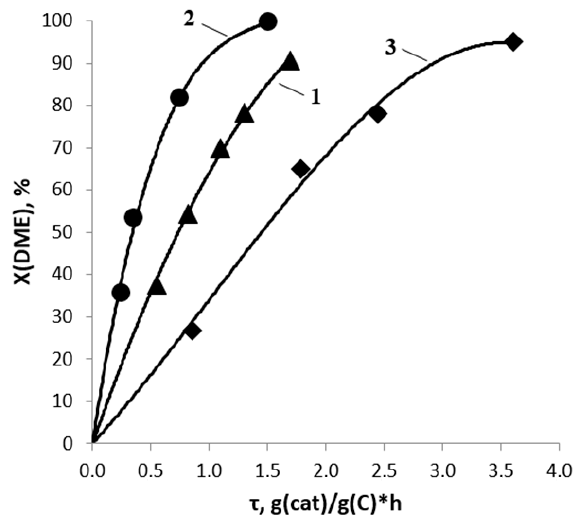
Figure 4. Conversion of DME (X (DME), %) as a function of specific contact time ( τ , g(cat) / g(C)*h). 1—HZSM-5 / Al 2 O 3 ; 2—Zr- HZSM-5 / Al 2 O 3 ; 3—Mg- HZSM-5 / Al 2 O 3 .